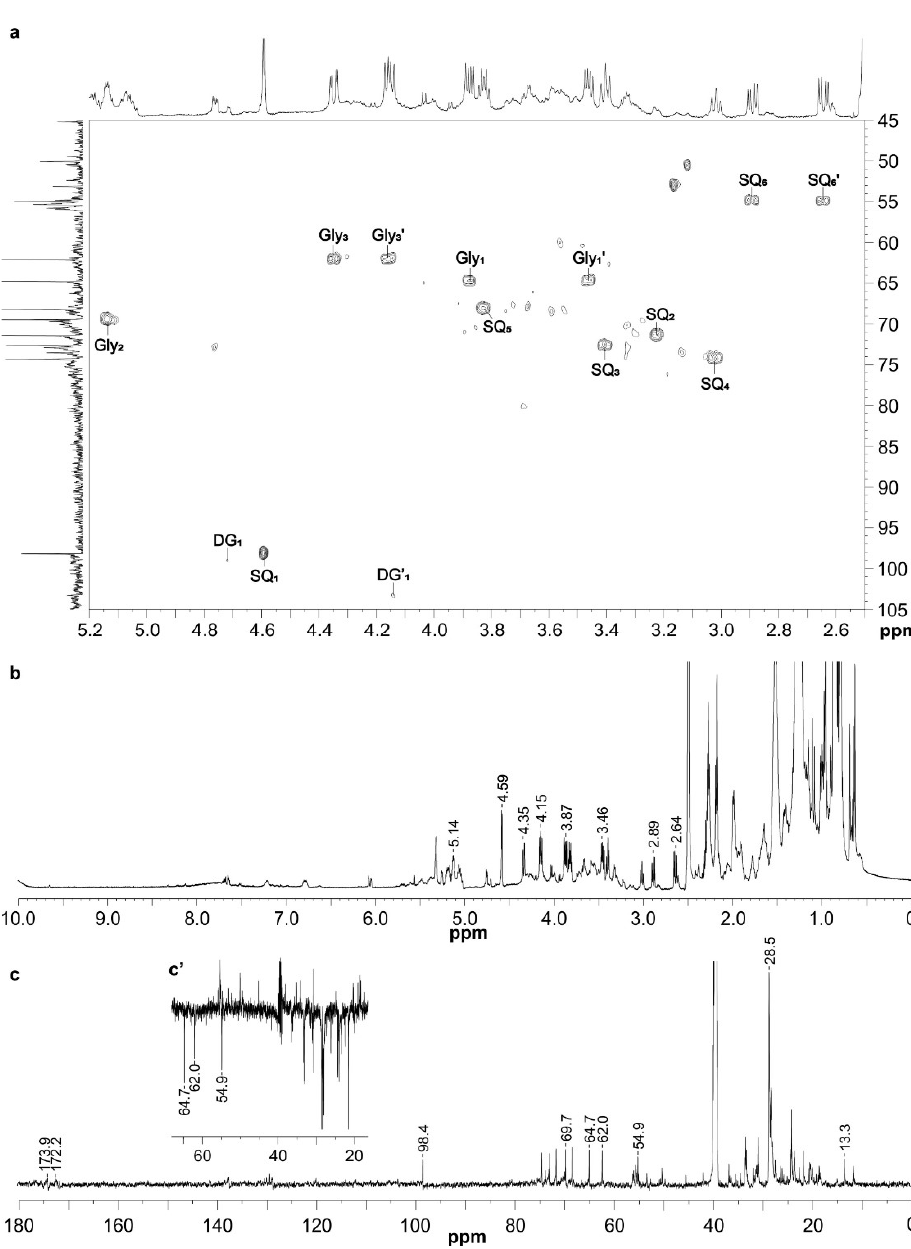
Figure 5. NMR analyses of the LA-p fraction. 1 H- 13 C HSQC ( a ), 1 H NMR ( b ), 13 C NMR ( c ), and partial 13 C-DEPT-135 spectra ( c’ ) (Me 2 SO- d 6 , 70 °C). DG, SQ, and Gly correspond to the glycosyl moiety of digalactosylglycerol and sulfoquinovosylglycerol, and the linked glycerol units, respectively.